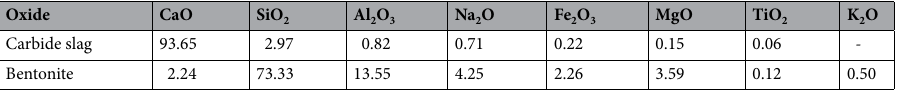
Table 1. Chemical compositions of the carbide slag and bentonite used, in oxide